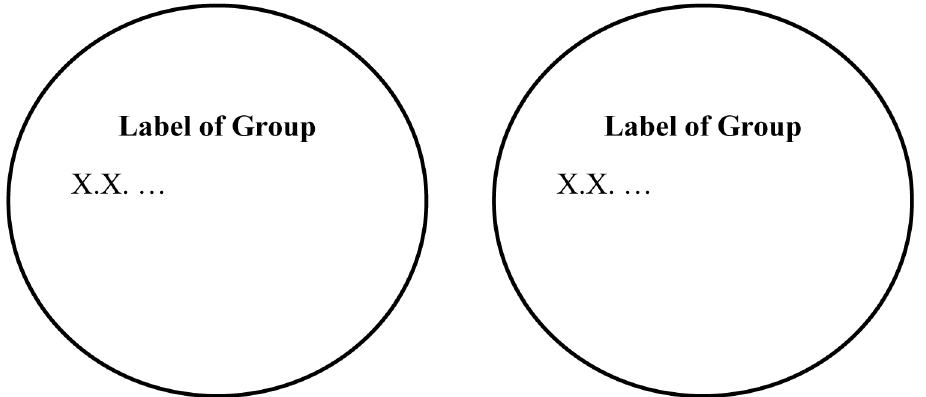
Fig 2. Example of how participants sorted their